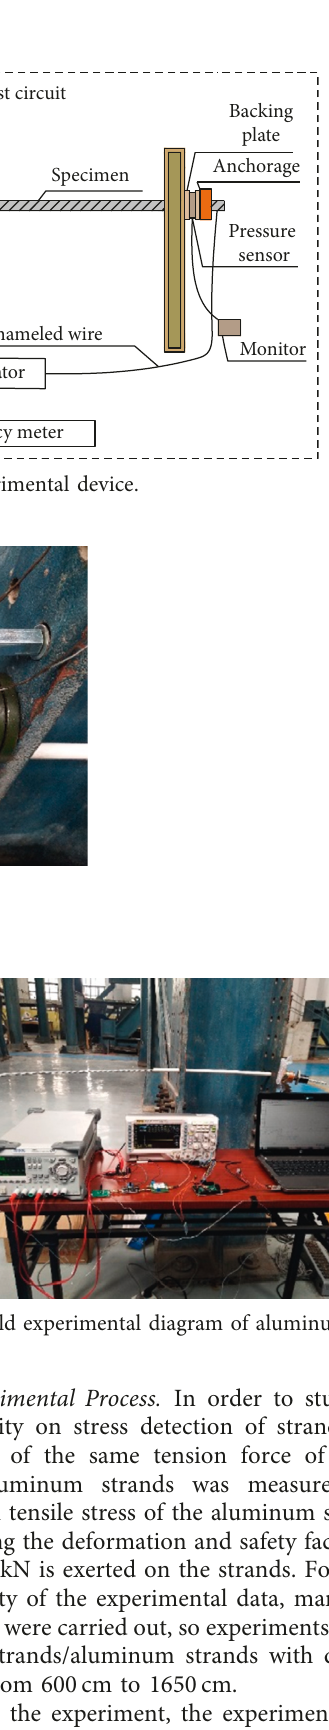
Figure 7: Circuit device diagram.